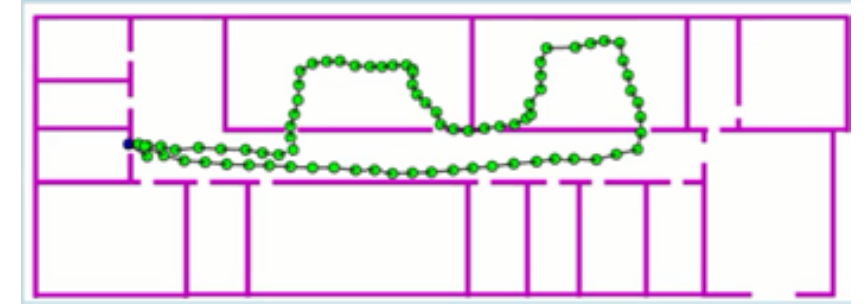
Figure 3. Positions obtained from radio INS. Between each of the consecutive pairs of points, the velocity of the agent is calculated, stating the input for the ORCA algorithm. The green dots represent the points where the positions were measured. The purple lines represent building obstacles.